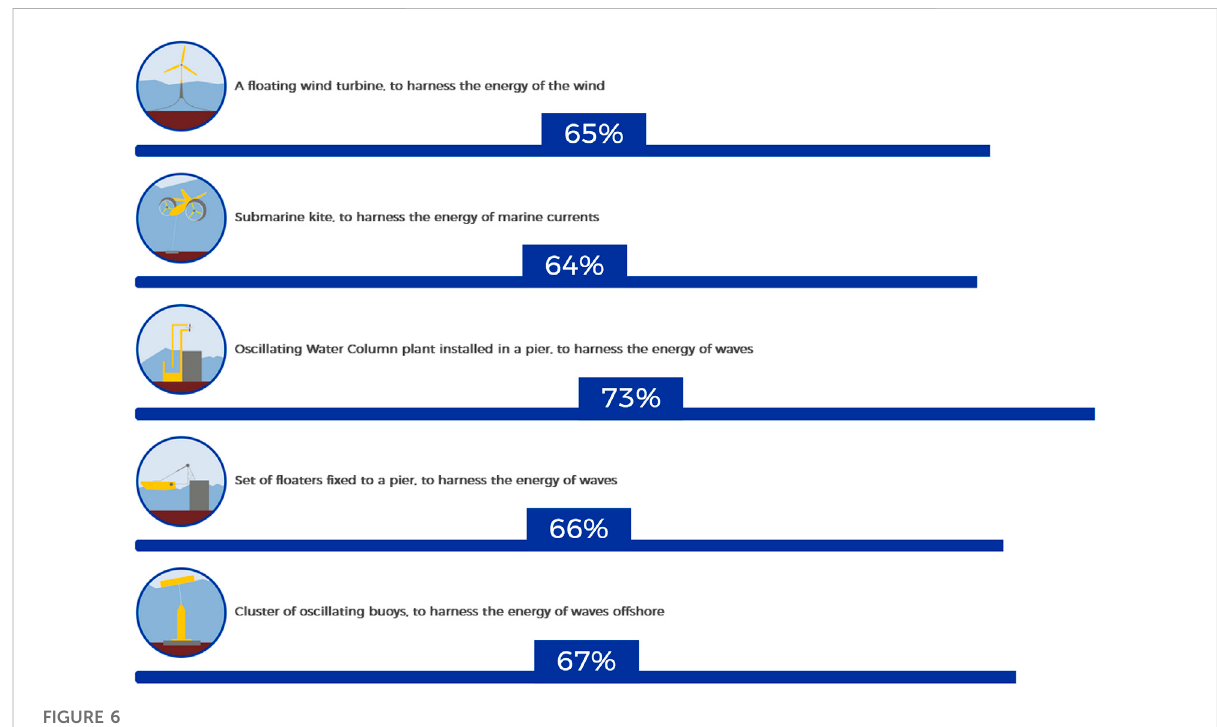
FIGURE 6 Support for